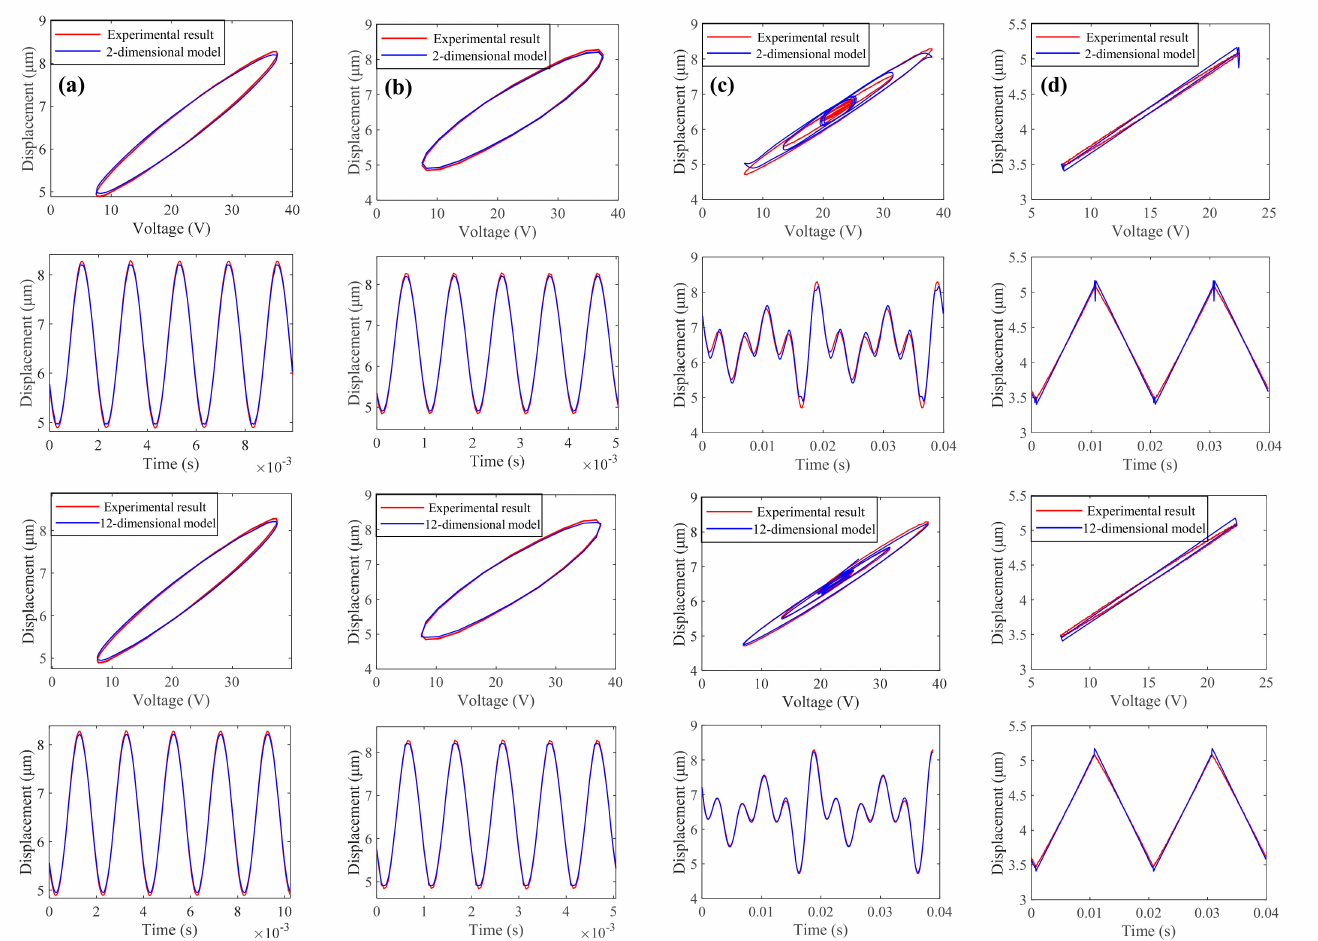
Figure 3. Experimental measured results of the PEA (red lines) as function of voltage and time for 500 Hz sinusoidal signal (column a panels); 1000 Hz sinusoidal signal (column b panels); four − frequency mixed − signal (column c panels); 50 Hz triangular wave (column d panels). The prediction results for 2 − dimensional and 12 − dimensional GP models are also plotted (blue lines) in the upper two and lower two panels,